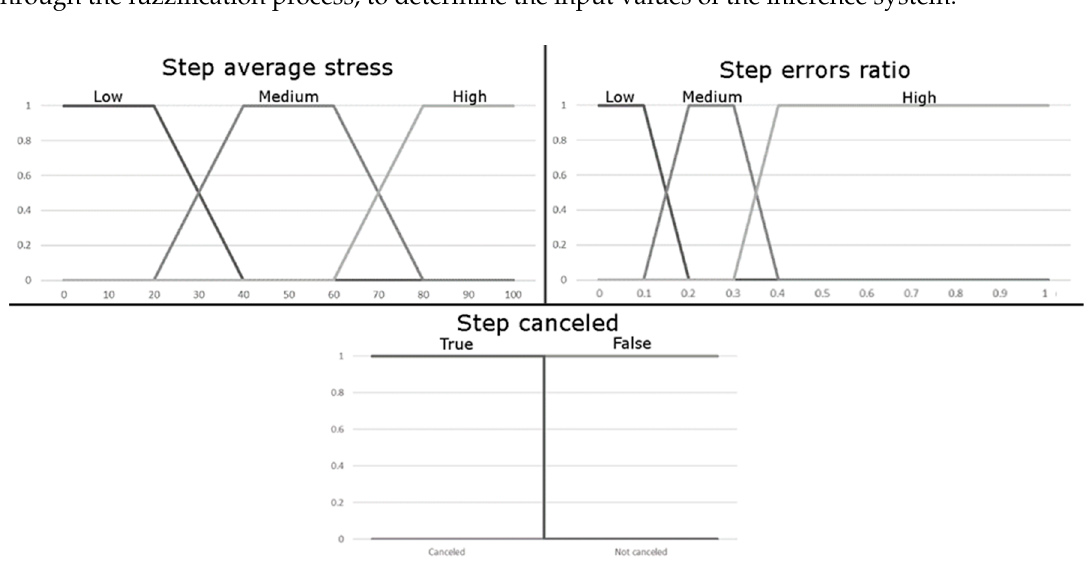
Figure 12. Input values of the FIS4D.